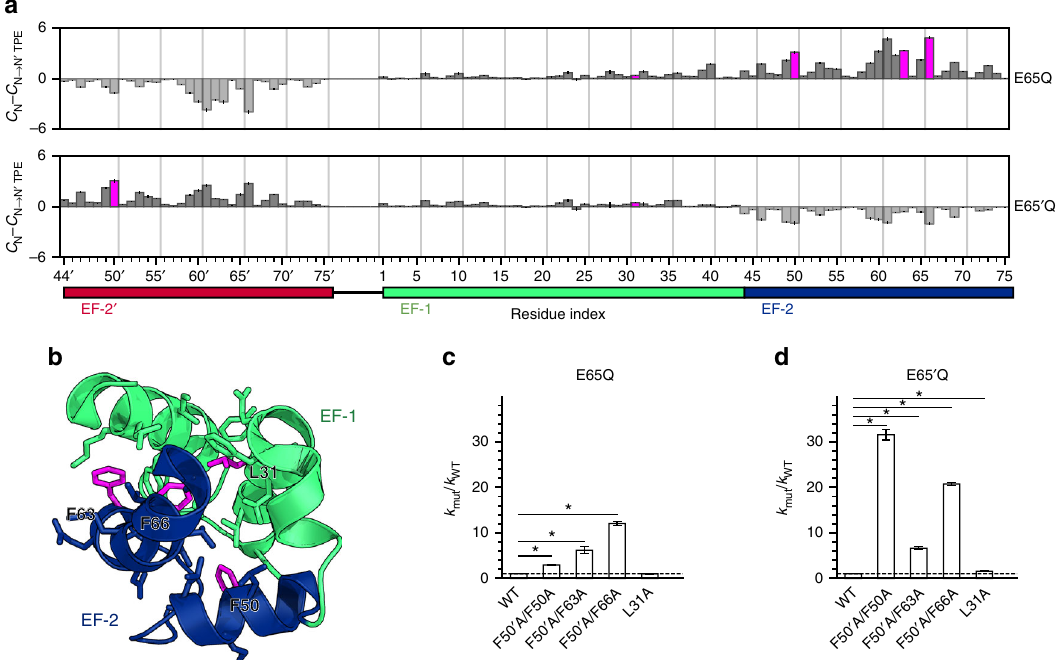
Fig. 4 Identi fi cation and testing of mutations for improving the switch response time. a Residues with contact scores that are substantially lower in the transition path ensemble (TPE) than the relevant ground state (magenta bars) were identi fi ed as candidates for improving the response time (see Supplementary Methods). Error bars indicate mean ± s.e.m.; n = 10 independent WE simulations. b Residues chosen for mutation (magenta) are located at the interface of the EF-1 and EF-2 hands (green and blue, respectively), as shown in this cartoon representation of the crystal structure of WT calbindin. The displayed side chains are of residues that are in close proximity (<5.5 Å) of the residue chosen for mutation. c , d Stopped- fl ow fl uorescence experiments reveal that all three pairs of promising mutations, F50 ′ A/F50A, F50 ′ A/F63A, and F50 ′ A/F66A, increase the rate constant for switching for both the WT E65Q ( c ) and WT E65 ′ Q constructs ( d ), thereby improving the switch response time. As predicted for the negative control, the L31A mutation has no effect on the rate constant for the E65Q construct ( k mut / k WT = 1.03; P = 0.24) and only marginally increases the rate constant for the E65 ′ Q construct ( k mut / k WT = 1.57; P = 10 − 7 ). Error bars indicate mean ± s.e.m., calculated using propagation of error; n = 15 stopped- fl ow experiments for